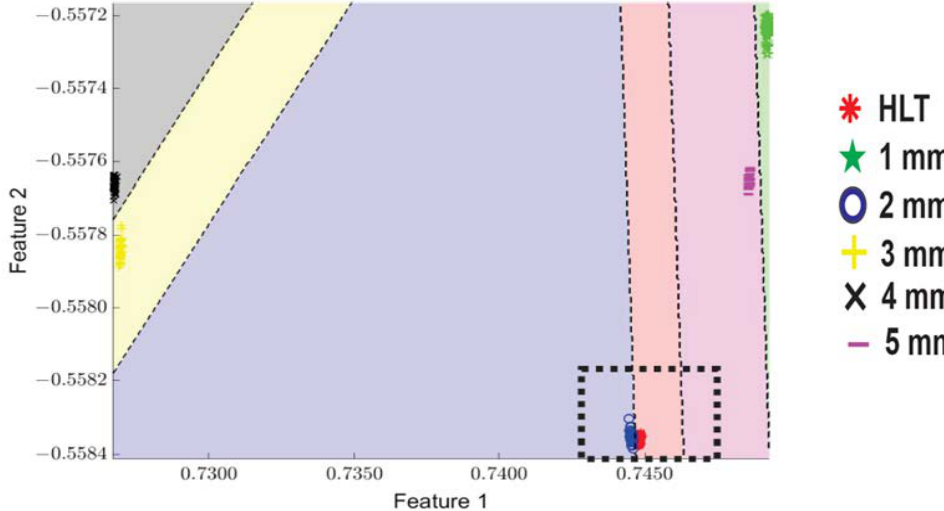
Figure 37. Projection of decisions region for multiple faults classification obtained by FFNN [99].